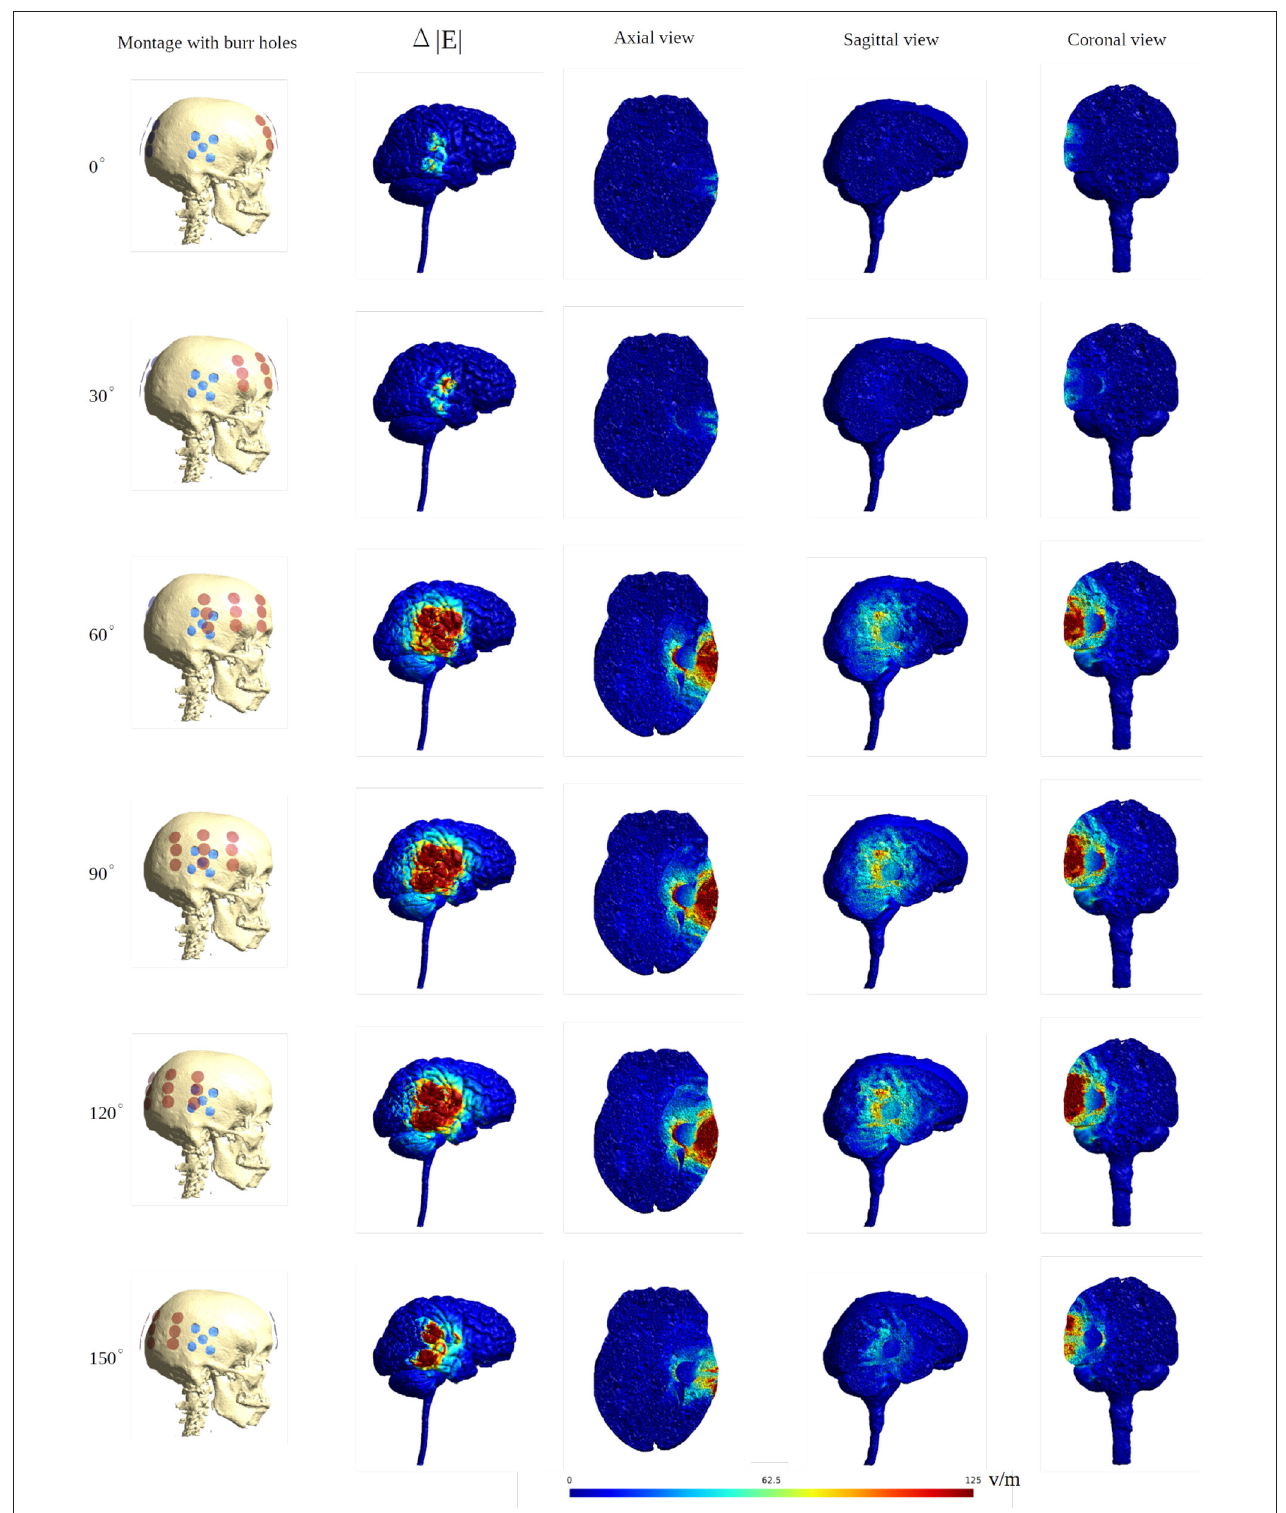
FIGURE 8 | Heat map of the electric field intensity enhancement for the exemplary rotational layouts with burr holes placed directly over the resection cavity and residual tumor. Enhancement occurs right underneath the burr holes and mainly when active transducers are located close to or directly overlapped with the burr holes. The red dots and blue dots in the first column represent the placements of the transducers and the burr holes, respectively. The second column shows the electric field enhancement on the gray matter surface. The following three columns give all three topographical views of the field enhancement.